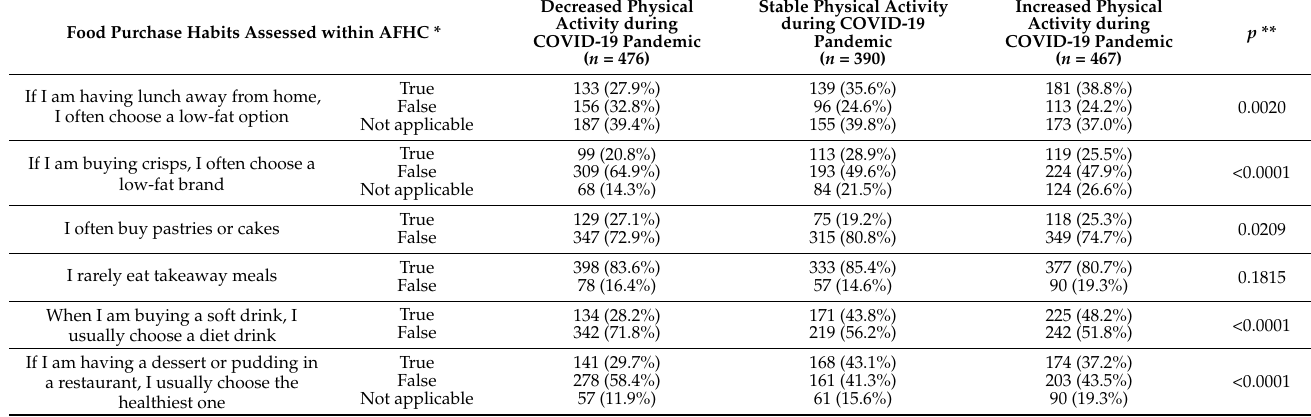
Table 7. The food purchase habits assessed while using Adolescents’ Food Habits Checklist (AFHC) in the period during the COVID-19 pandemic, as declared by the adolescents from the Diet and Activity of Youth during COVID-19 (DAY-19) Study cohort ( n = 1333) in sub-groups of adolescents declaring decreased, stable, and increased physical activity during the COVID-19 pandemic.